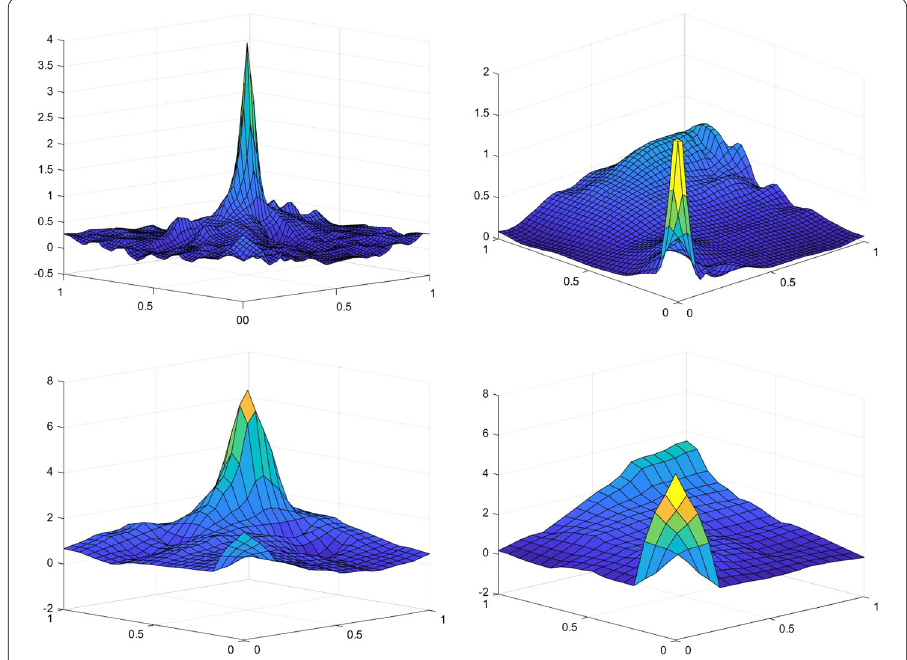
Figure 4 Wavelet smoothing of n = 2000 pairs of normalized ranks from Gumbel (left column) and Clayton (right column). ( a , top left) and ( b , top right) show wavelet estimators under censored data at level j = J – 1 with J = 5 for Gumbel and Clayton copula, respectively. ( c , bottom left) and ( d , bottom right) show wavelet estimators under censored data at level j = J – 2 with J = 5 for Gumbel and Clayton copulas, respectively